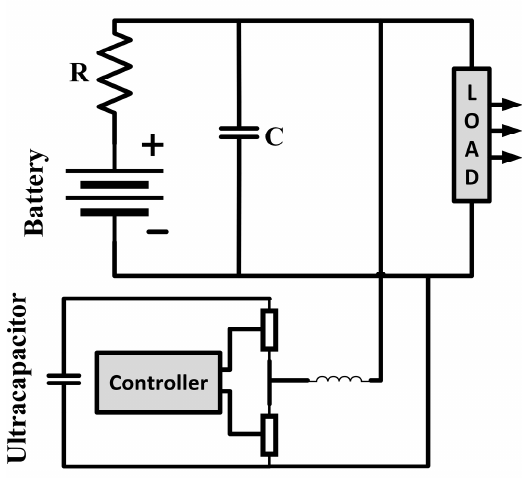
Figure 30. Combination of battery and UC to complement each-other’s shortcomings [59].